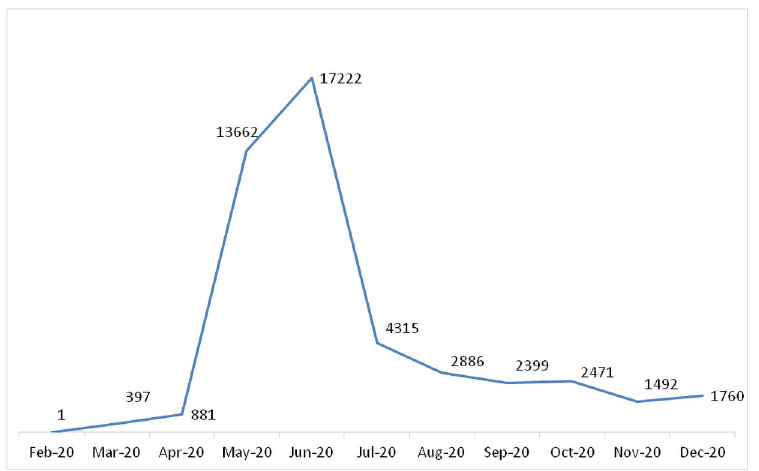
Fig 6. Number of COVID-19 positive cases by month in Qatar in